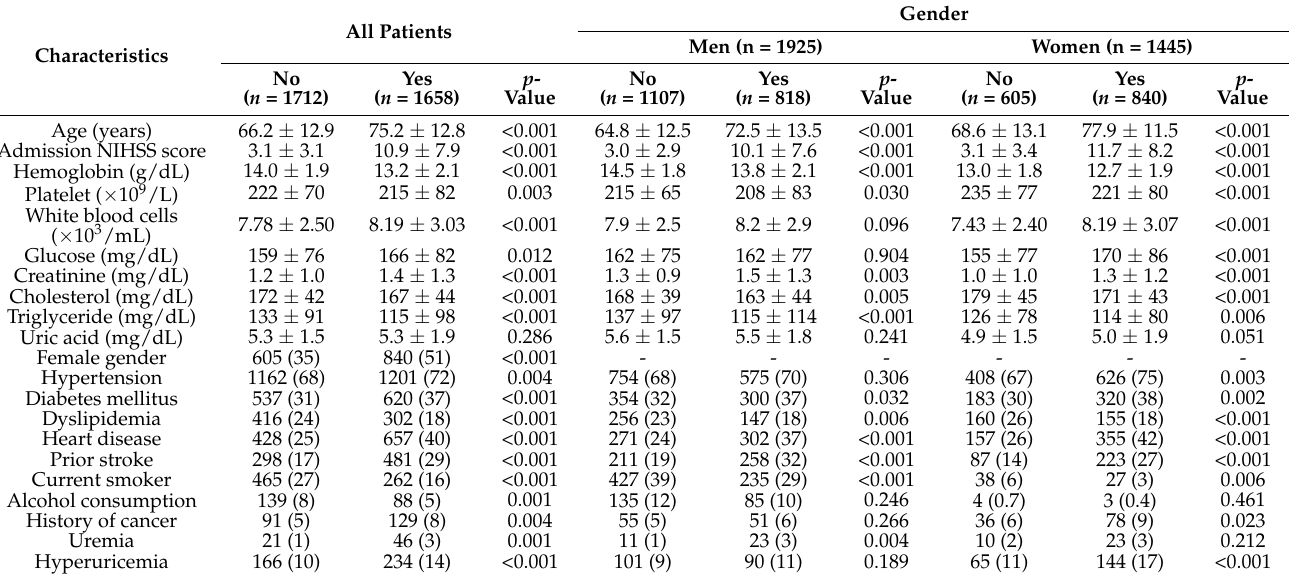
Table 2. Univariate analysis of factors related to unfavorable outcomes (modified Rankin Scale score > 2) in 3370 patients with acute ischemic